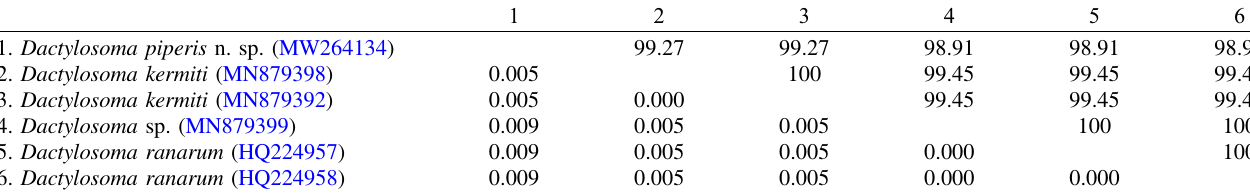
Table 3. The shaded matrix (upper) shows the percentage of similarity (%) of the nucleotide sequences and the non-shaded matrix (lower) shows the p-distance (pair-wise distance) between the Dactylosoma sequences in anurans available at GenBank (452